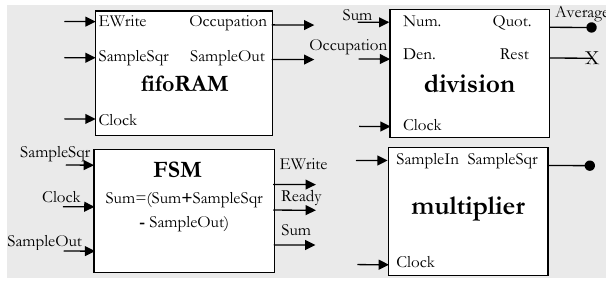
Fig. 10. Core root mean square version. Table 1. Algorithm